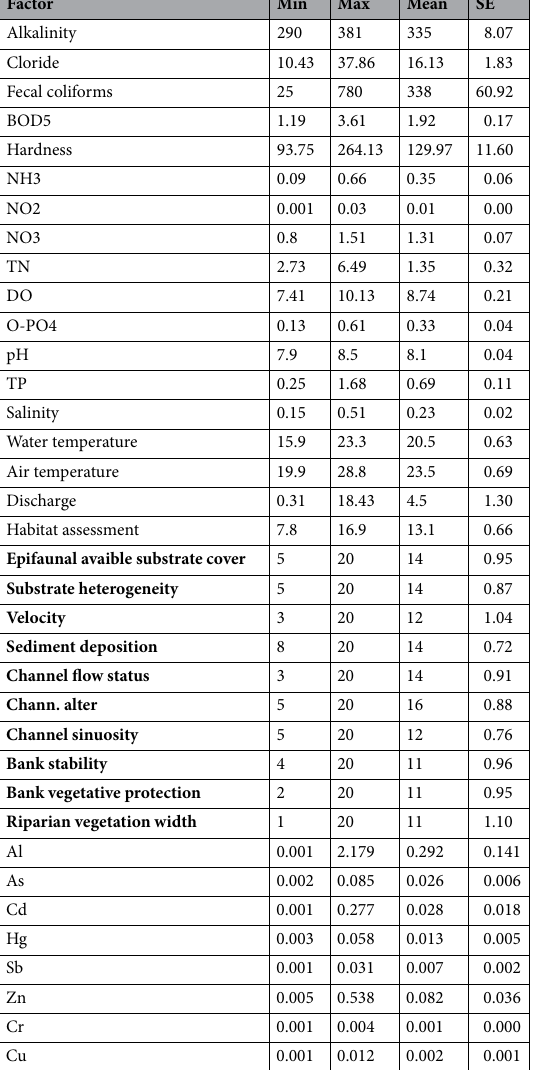
Table 1. Selected environmental factors for further analysis at 15 study sites. Bold factors are those included in the visual-based habitat assessment. BOD 5 biochemical oxygen demand of 5 days, TN total nitrogen, DO dissolved oxygen, TP total